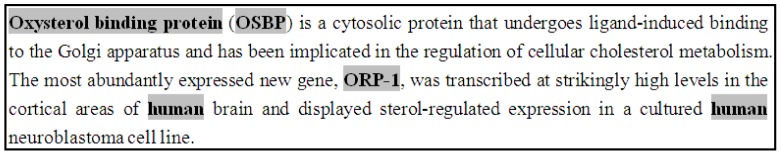
Excerpt from the abstract with PubMed ID “10588946” and partial annotation information of genes with name “ORP-1” in Entrez Gene.